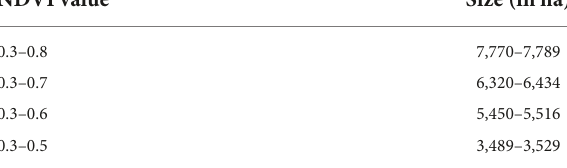
TABLE 4 The estimation of the potential rangeland in a 5 km radius survey area around the Bronze Age Stepnoye settlements in July and August